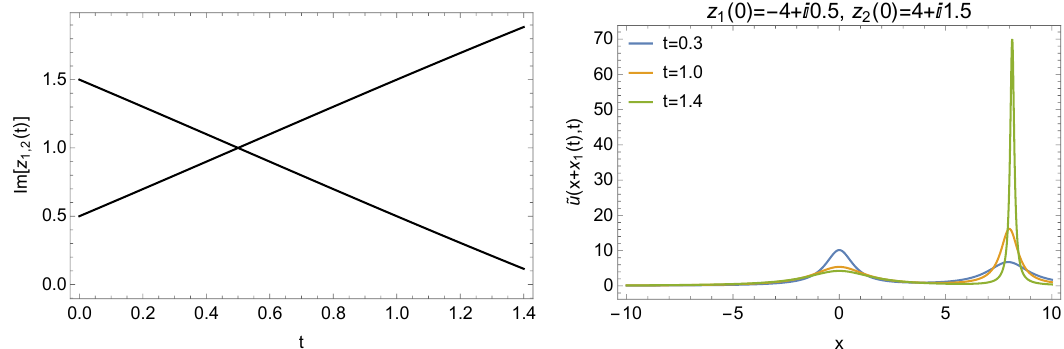
Figure 6: (Left) Dynamics of the imaginary part of the two poles given by Eq. 75. One of the poles hits the real axis at finite time. (Right) Two soliton profile ˜ u ( x , t ) for different times t = 0.3,1.0,1.4 governed by the pole dynamics plotted on the left. One of the soliton profiles widens whose pole moves away from the real axis and the other soliton keeps sharpening while moving to the right (relative to the first soliton) and diverges at the time when the pole hits the real